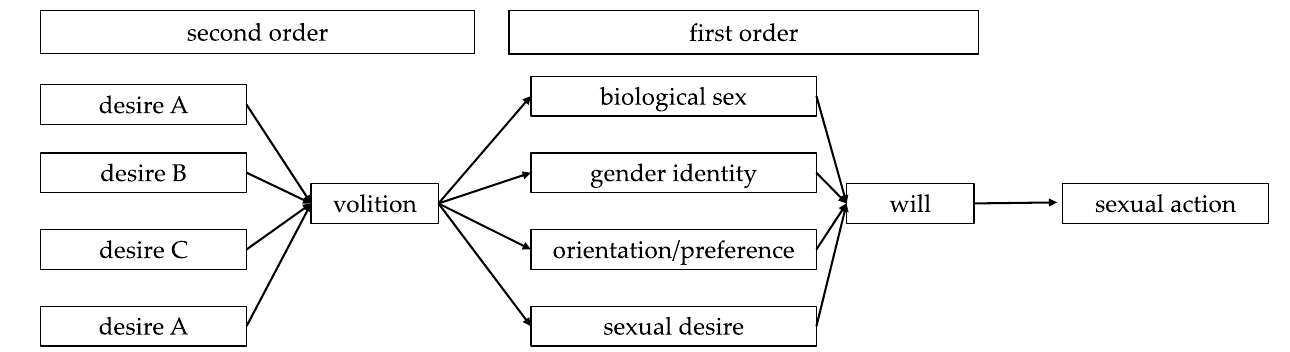
Figure 1. Depiction of the architecture of sexual self-determination developed in this paper (according to Harry Frankfurt). The sexual action is the result of a reflective process which takes place on several hierarchical levels (in the language of Harry Frankfurt “orders”; for reasons of clearness, only two levels = orders are depicted). The will causes a sexual action. Sexual self-determination is the act which results in a sexual will. Sexual dimensions on the first hierarchical level are reflected upon on higher levels. The volition of the second order refers to all sexual dimensions and is itself determined by all higher-order desires.